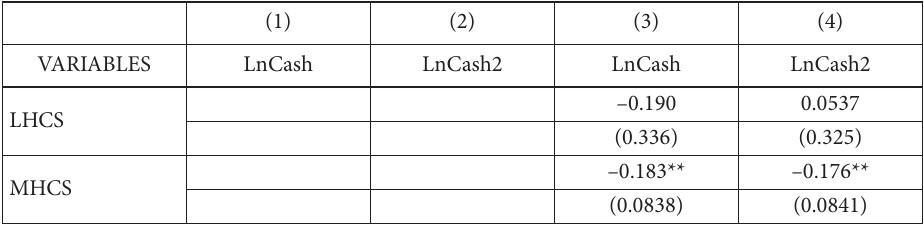
Table 5. 2sls instrumental regression (hierarchical CEO succession and cash